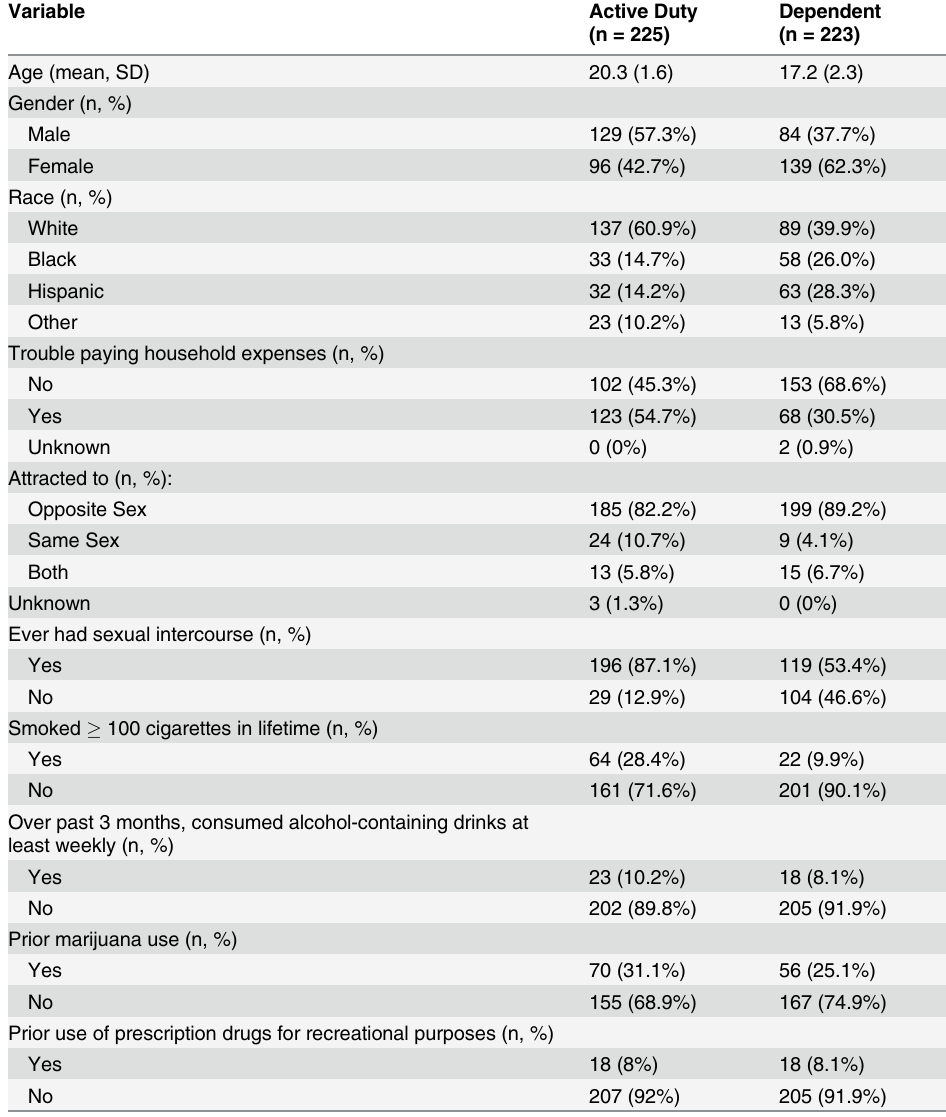
Table 1. Characteristics of participants who presented for care in military adolescent clinics (n = 448).